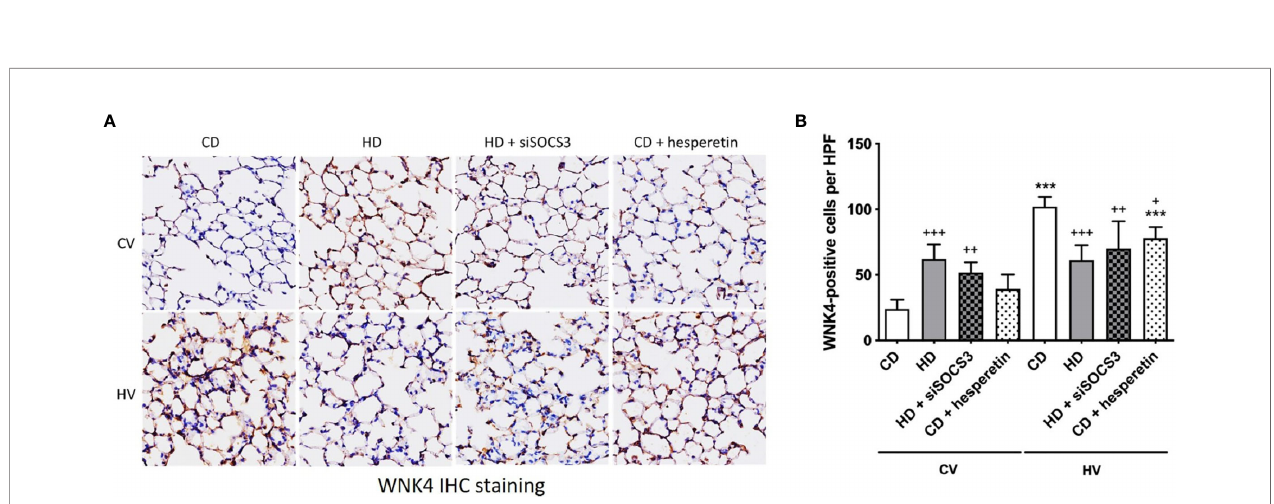
FIGURE 6 | WNK4 expression in obese mice and after SOCS3 manipulation. The specimens were stained in nonobese mice (CD), obese mice (HD), obese mice pretreated with an intratracheal spray of SOCS3 siRNA (HD + siSOCS3), and nonobese mice pretreated with hesperetin enterally (CD + hesperetin) after 6 h of spontaneous breathing (CV) or mechanical ventilation (HV). (A) Immunohistochemical staining of WNK4. (B) Quanti fi cation of WNK4 expression. Data are expressed as the mean ± SE (n = 5 per group). *** P < 0.001 compared with the corresponding group in the CV condition. + P < 0.05, ++ P < 0.01, and +++ P < 0.05 compared with the nonobese mouse group (CD).